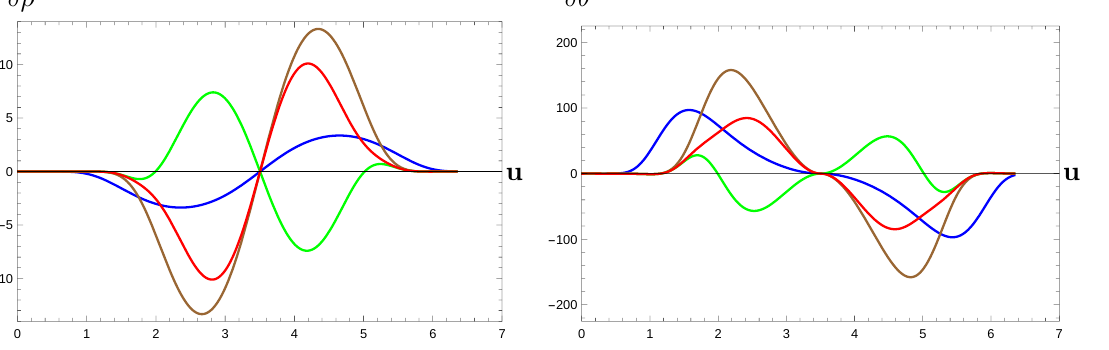
Figure 14. Plot of (cid:14)(cid:26) for h = 326 for four di(cid:11)erent number of terms i) N = 5 (blue), ii) N = 21 (brown), iii) N = 33 (green) & iv) N = 43 (red).